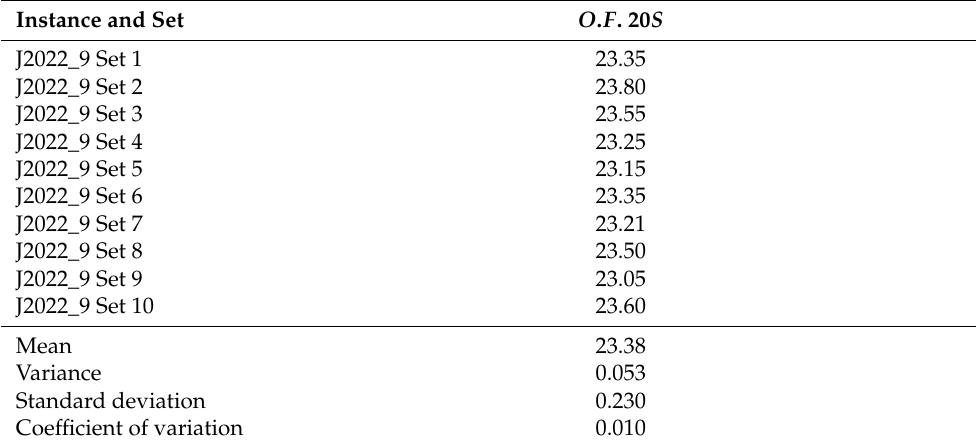
Table 7. Experiment 1 results. Generation of